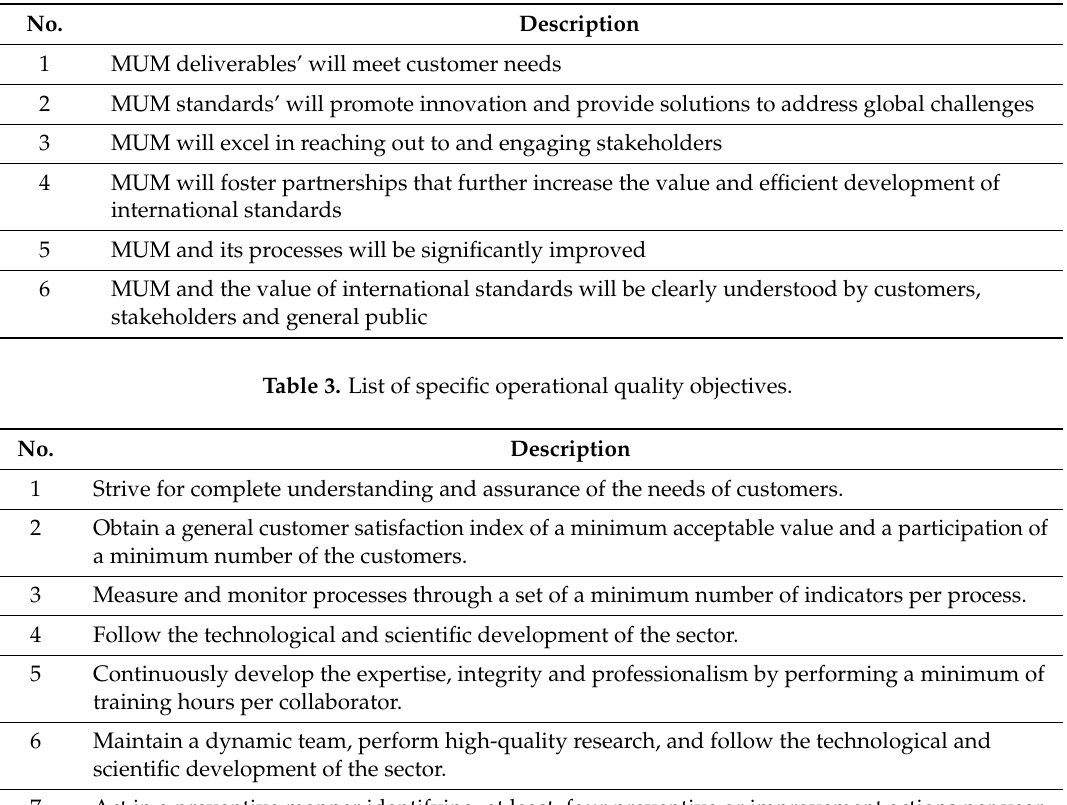
Table 2. List of general quality objectives of MUM.